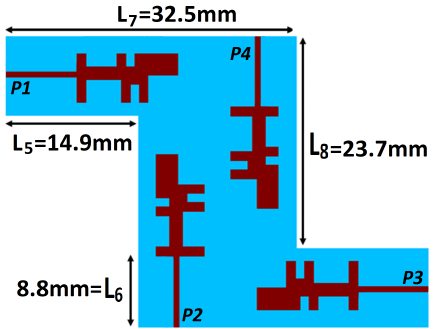
Figure 4. Geometric layout of MIMO antenna